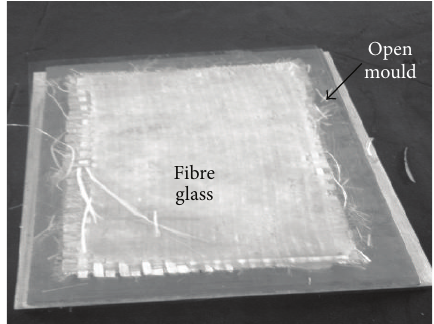
Table 2: Type of glass fibre.